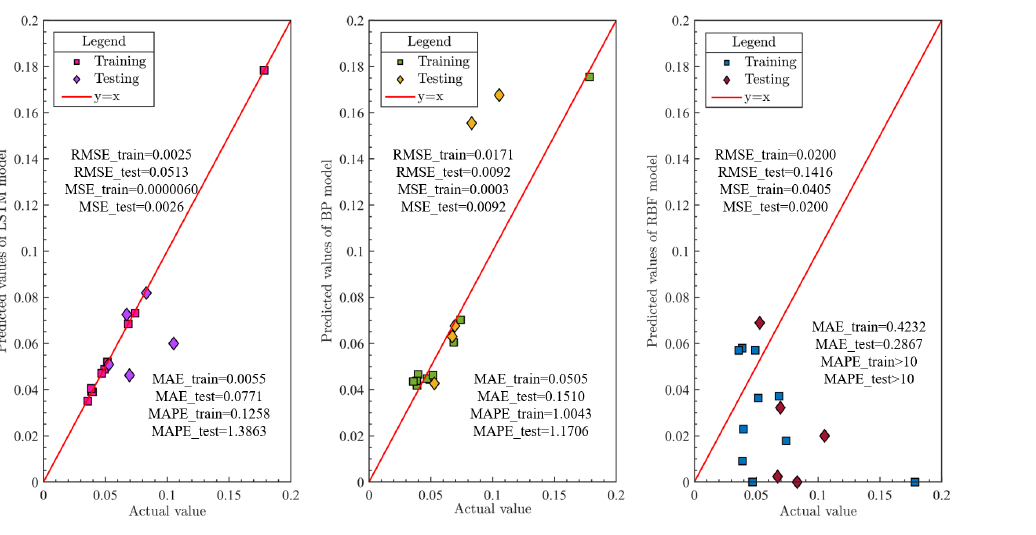
Figure 6. Evaluation score results histogram: model training and prediction.